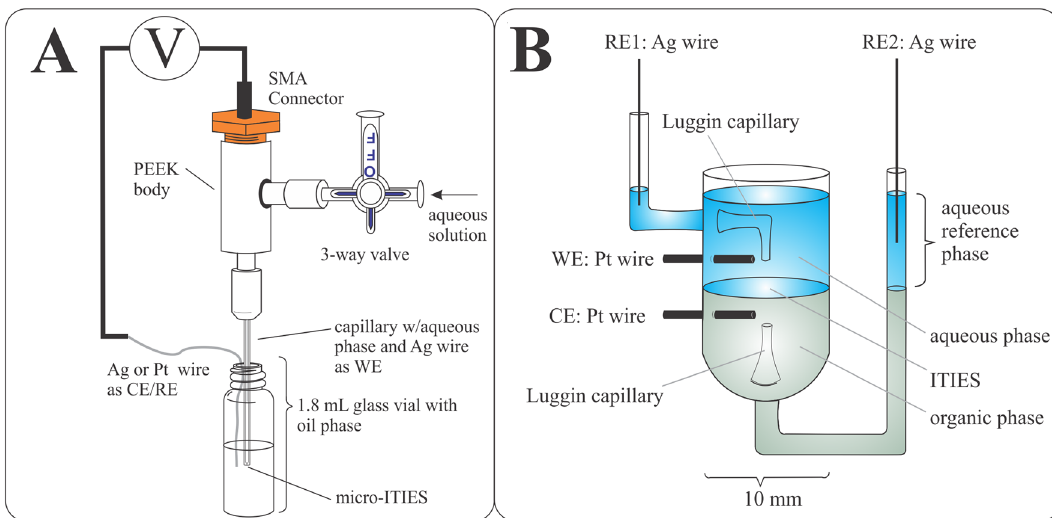
Figure 1. Diagram of the specialized ( A ) micro and ( B ) large ITIES (interface between two immiscible electrolyte solutions) cell. WE, CE, and RE refer to the working, counter and reference electrode leads,